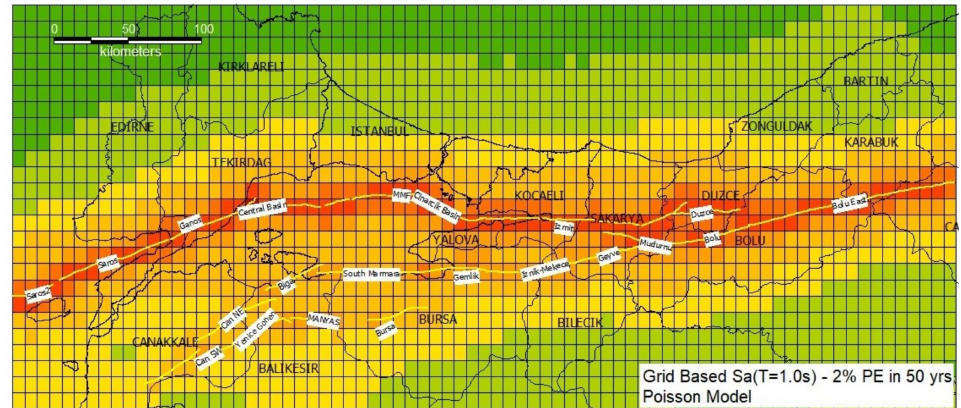
Figure 19. Grid-based SA (T = 1.0 s) distribution at NEHRP B / C boundary site class for 10% (upper panel) and 2% (lower panel) probabilities in 50 years (Poisson model). Color coding is the same as in Figure 17.